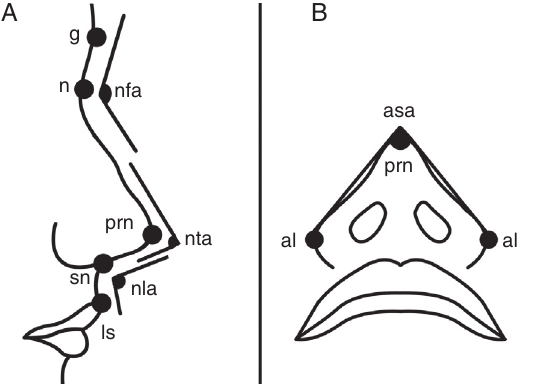
Figure 1 Facial and nasal soft tissue landmarks. (A) Facial soft tissue landmarks of glabella (g), nasion (n), pronasale (prn), subnasale (sn), labiale superius (ls) and angles of nasofrontal (nfa), nasal tip (nta), and nasolabial (nla) were demonstrated on lateral view. (B) Facial soft tissue landmarks of alare (al), pronasale (prn) and alar slope angle (asa) were demonstrated on basal view.